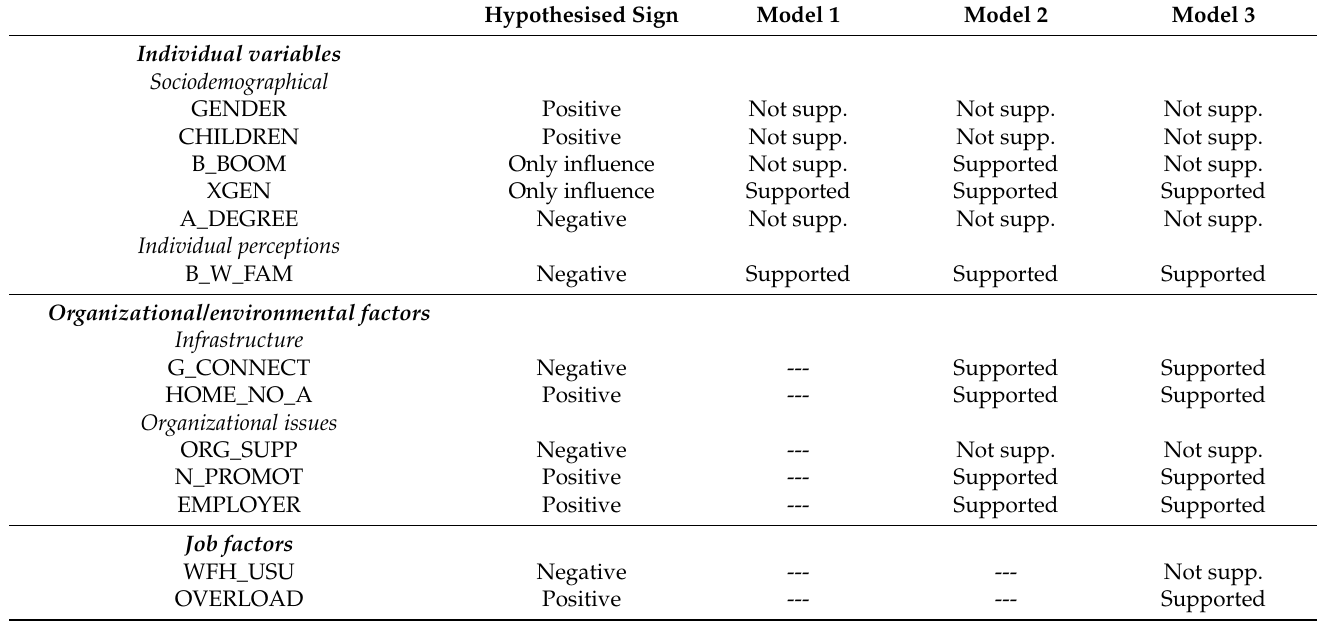
Table 6. Decision on the acceptance of hypothesis regarding isolation perception